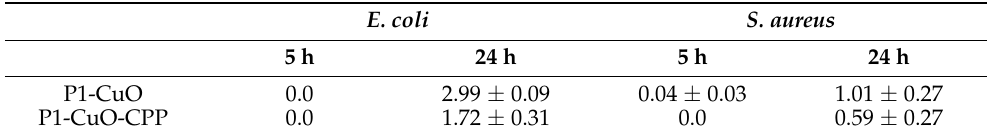
Table 1. Microbicidal effect (ME) evaluated for P1-CuO and P1-CuO-CPP scaffolds against E. coli and S. aureus at 5 and 24 h of contact. One-way ANOVA, Scheff é test ( p ≤ 0.05) is reported in the Supplementary Information (SI: Section S1.3.6).